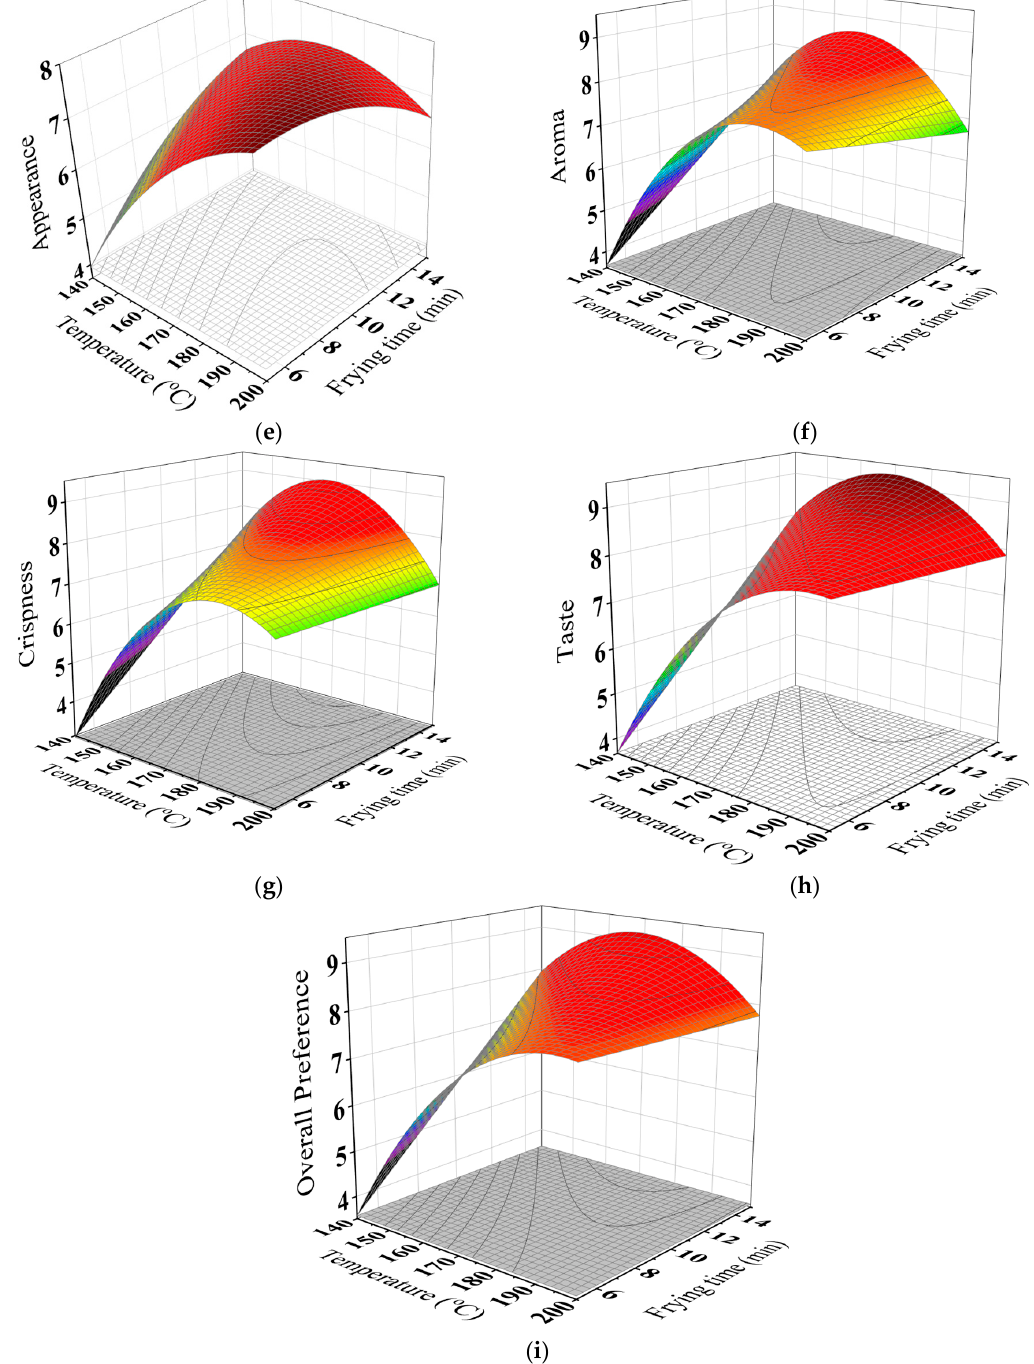
Figure 3. Response surface for ( a ) MC (w.b. %), ( b ) hardness (N), ( c ) FC (d.b.%), ( d ) L*-value, ( e ) appearance, ( f ) aroma, ( g ) crispiness, ( h ) taste, and ( i ) overall preference of the fried falafel at different frying conditions.